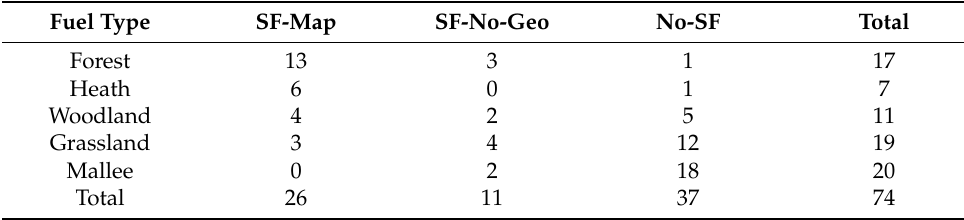
Table 5. Count of fires by fuel type and suppression firing